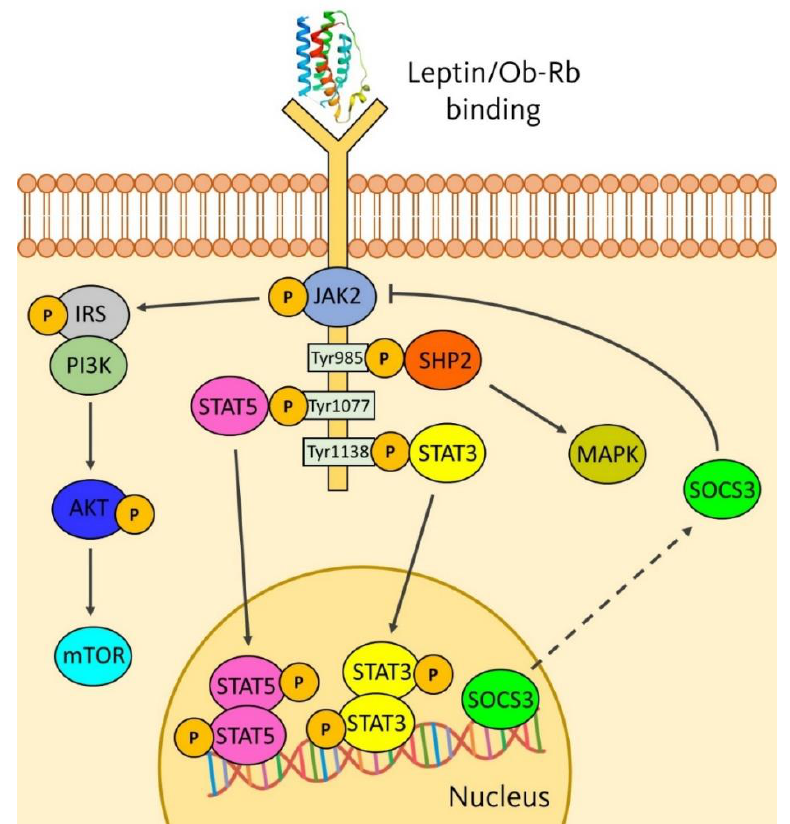
Figure 1. Mechanism of leptin action and activation of signalling pathways.